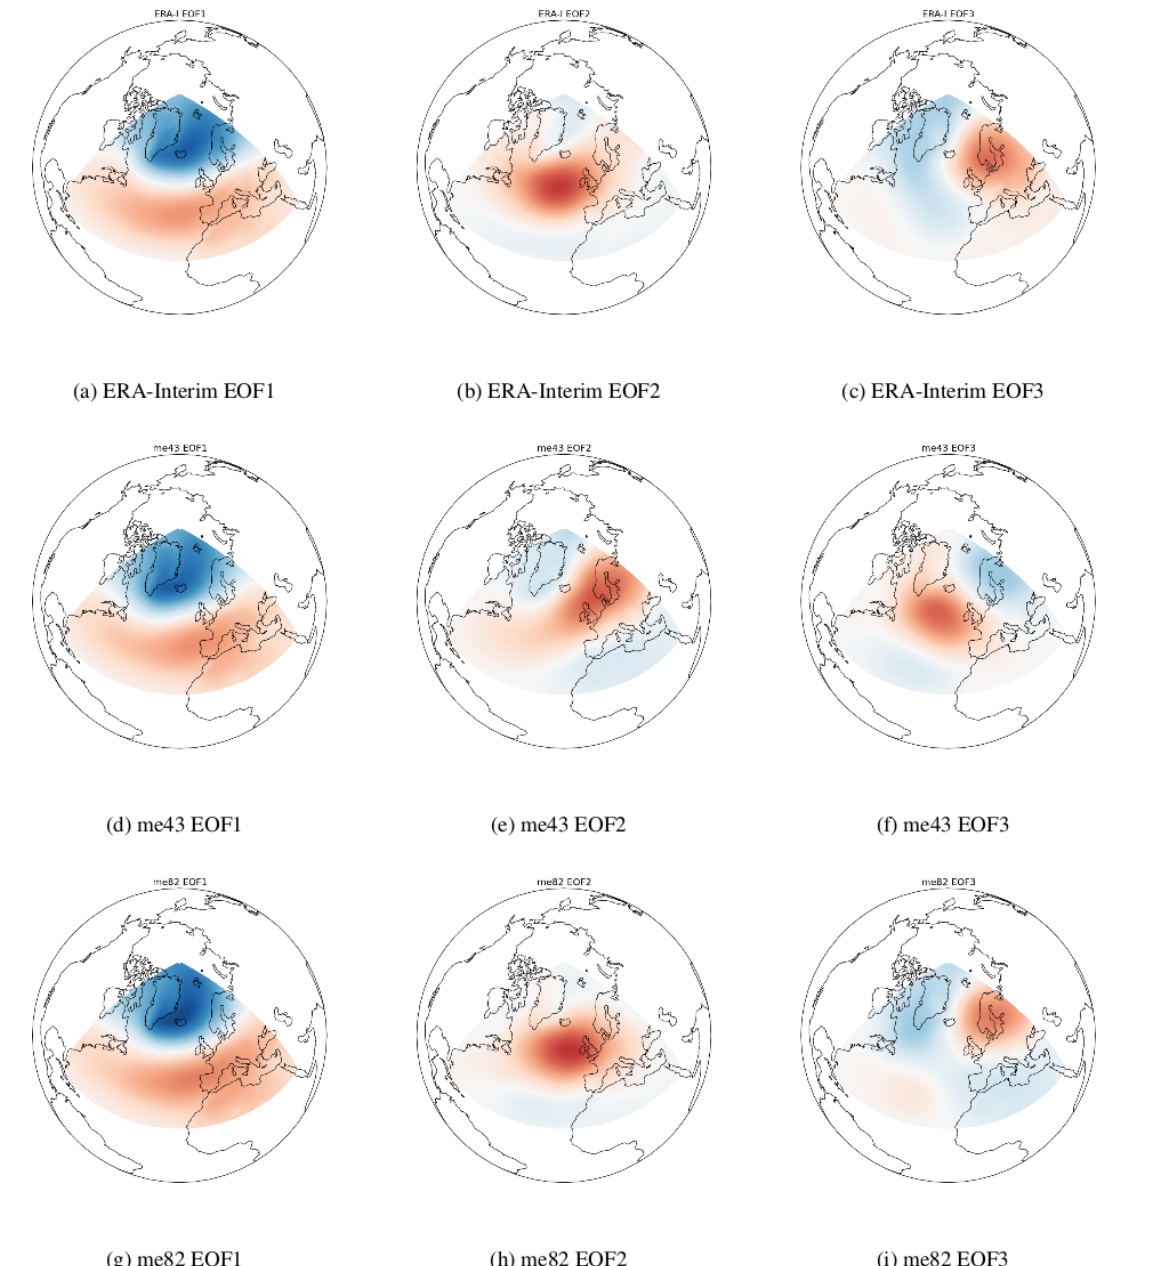
Figure 2. The first three EOF patterns for ERA-Interim (a) to (c) , EC-Earth me43 (d) to (f) and EC-Earth me82 (g) to (i) .